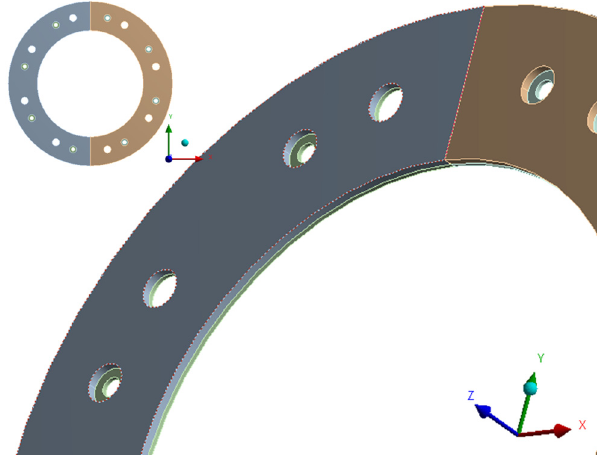
Figure A1. Split geometry of the friction facing.